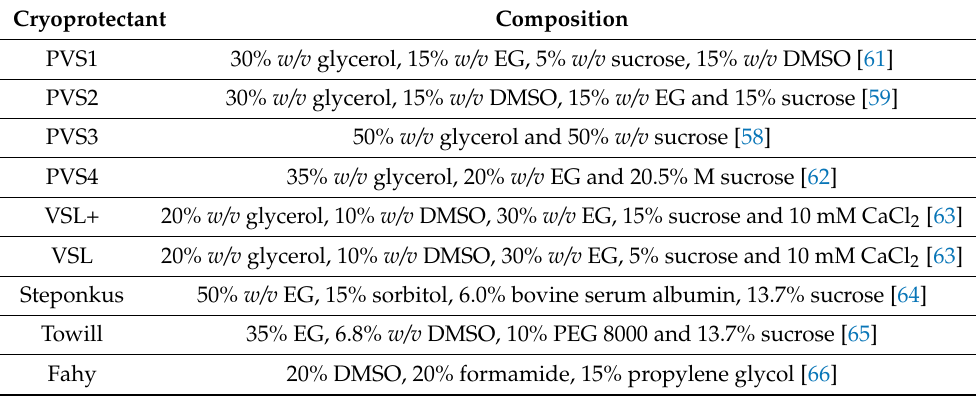
Table 4. Some examples of cryoprotectants used for plant tissue.